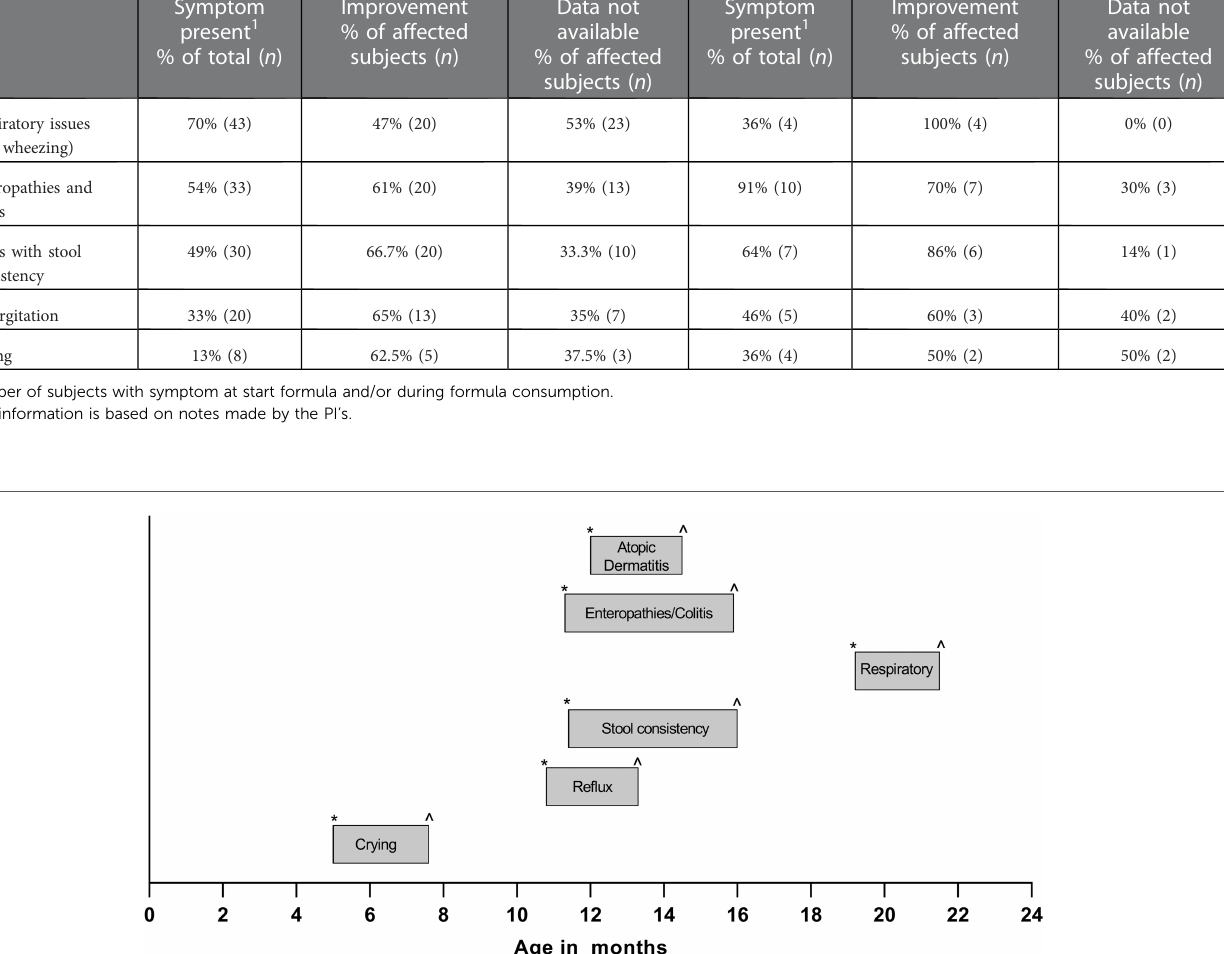
TABLE 7 Prevalence and course of other symptoms in both groups, presented as percentages (number of subjects)*. Symptom